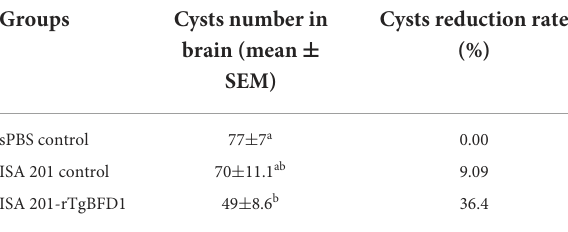
TABLE 1 The number of PRU cysts in rTgBFD1 pre-immunized mice brain.